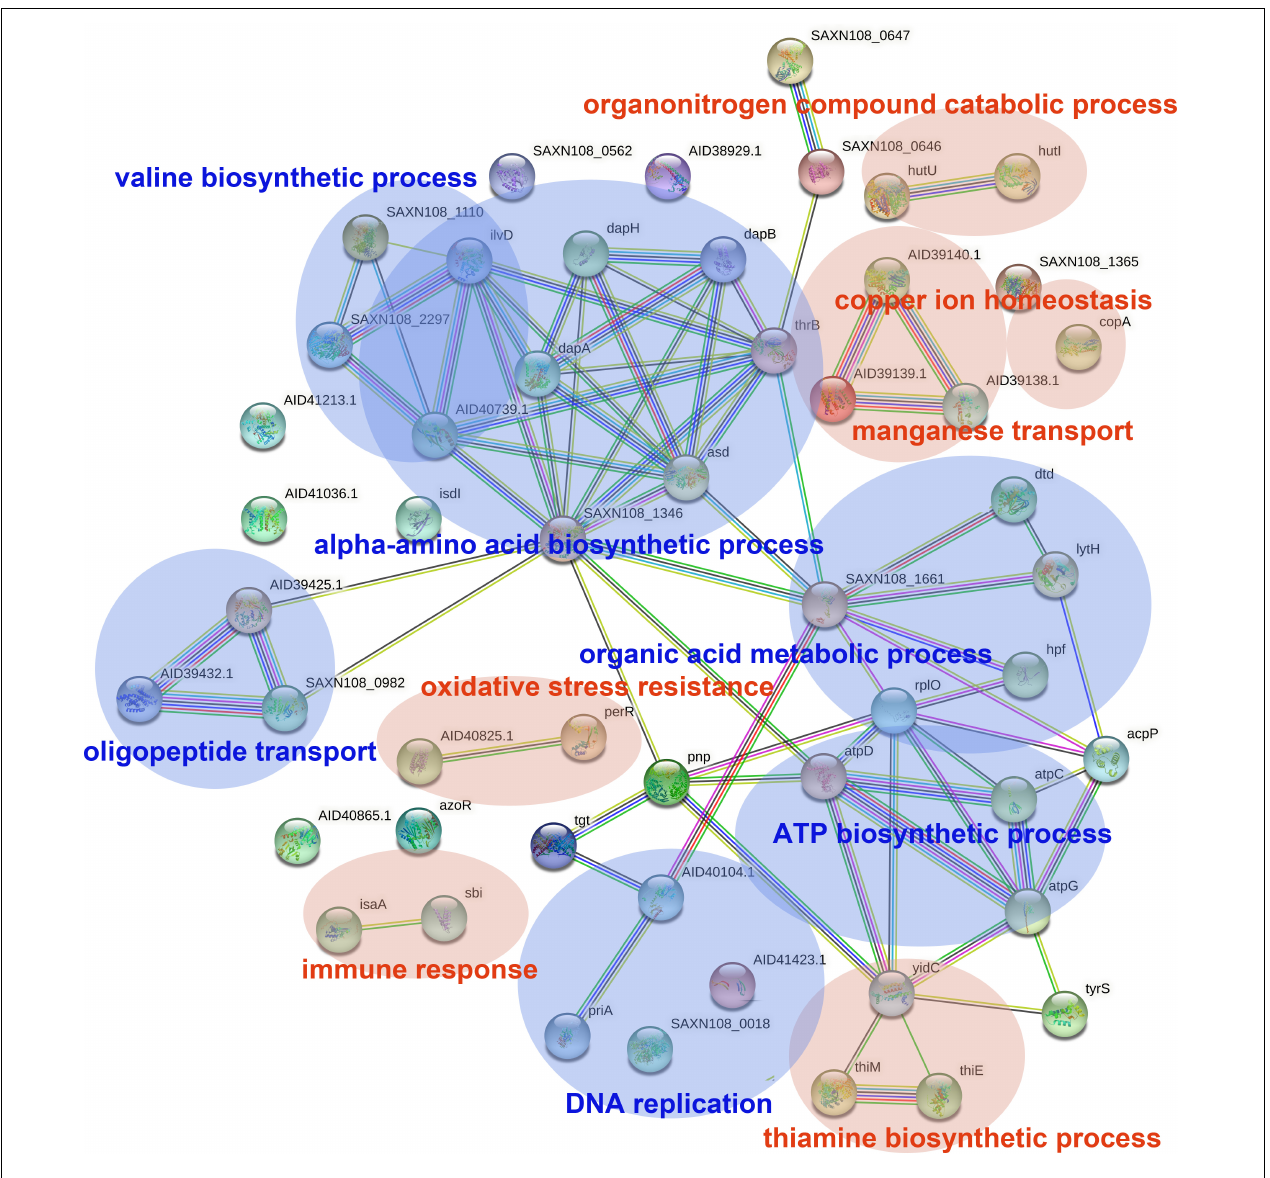
FIGURE 6 | PPI network of DEGs in stationary phase. PPI, protein–protein interaction. Circles represent genes, lines represent protein interactions, and the structures of proteins are shown in the circles. Line color represents evidence of the interaction between the